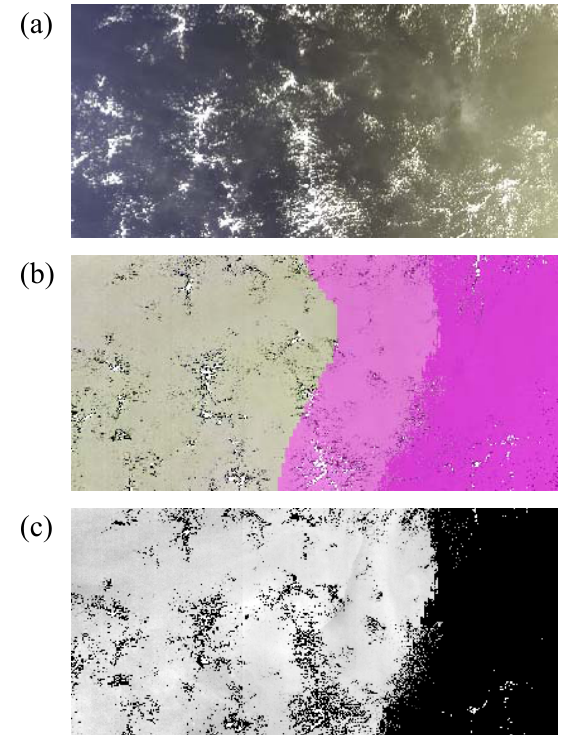
Figure 5. Illustration of MERIS glint correction and masking, in an image of part of the South Pacific. (a) Level 1 image, with glint apparent on the right side. (b) Level 2 image, masked to show the areas of moderate glint (light pink) and high glint (dark pink). (c) Level 2 image showing the calculated levels of chlorophyll 1—no retrieval can be made in the high glint region, or cloudy areas, but retrieval is considered sufficiently accurate in the moderate glint region where glint has been